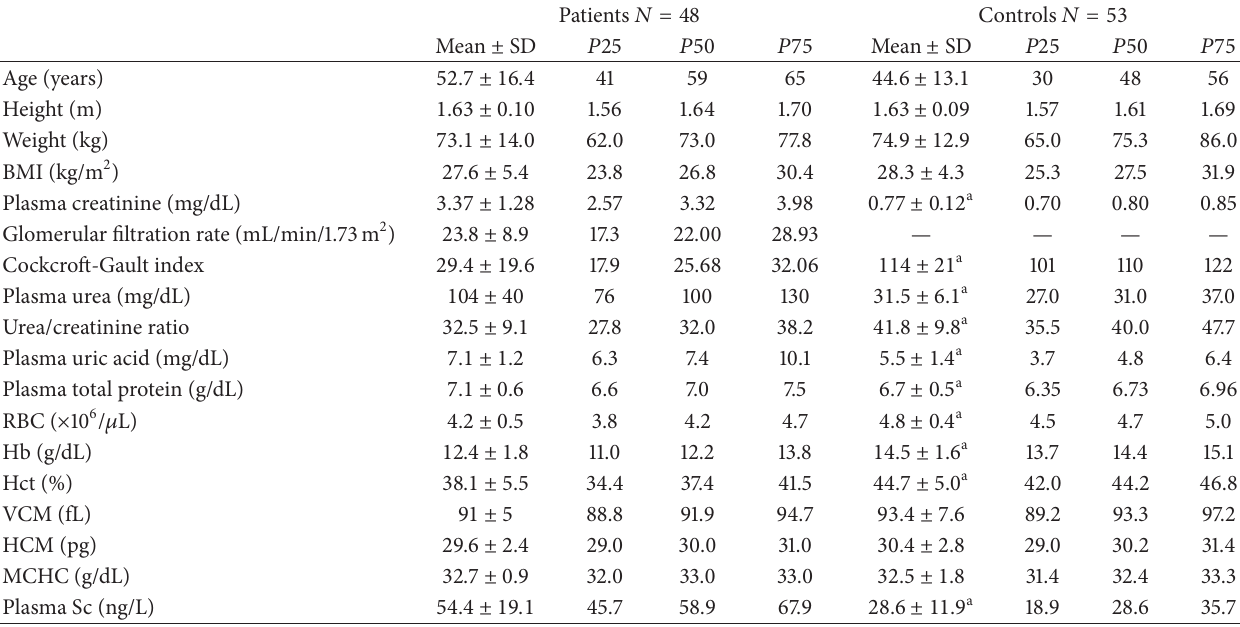
Table 1: Anthropometric, biochemical, and haematological variables and plasma levels of Sc in patients and